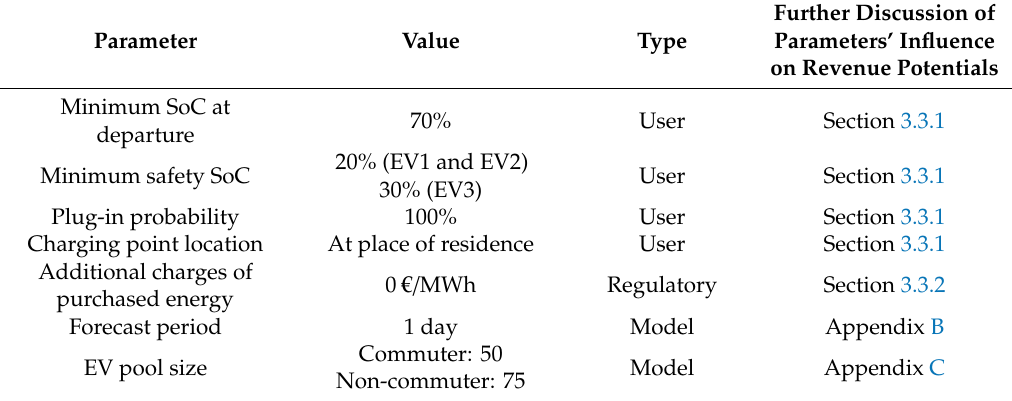
Table 3. Fixed user, modeling and regulatory parameters for the investigation of revenue